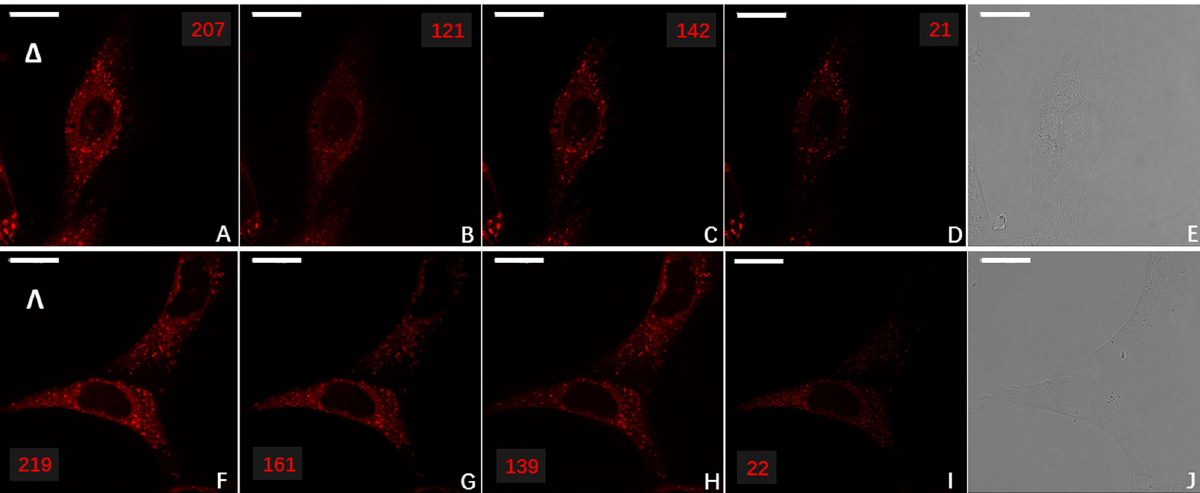
Fig. 5 Enantioselective localisation of enantiopure europium complex, Eu:L1 to the lysosome or mitochondria in live NIH 3T3 cells. Enantioselective differential chiral contrast (EDCC) CPL-LSCM of Eu:L1 (30 µ M, 14 h loading, ×63 1.4 NA oil objective, 96 × 96 µ m FOV, 100 avg., 790 nm axial section) in live mouse skin fi broblast (NIH 3T3) cells, showing enantioselective localisation to the lysosome ( Δ -Eu:L1) and mitochondria ( Λ -Eu:L1). Top row Δ -Eu:L1. A Total Europium emission ( λ ex = 355 nm, 20 mW, λ em = 589 – 720 nm). B , C Left and Right CPL channel ( λ ex = 355 nm, λ em = 589 – 599 nm), respectively. D Left-handed EDCC image (left CPL — right CPL) highlighting enantioselective predominantly lysosomal localisation. E Transmission image. Bottom row Λ - Eu:L1. F , G , H , J as per ( A , B , C , E ). I Left-handed EDCC image (left CPL — right CPL) highlighting enantioselective predominantly mitochondrial localisation. Scale bars = 20 µ m, numbers in red are avg. Eight-bit pixel intensity values for each image region.